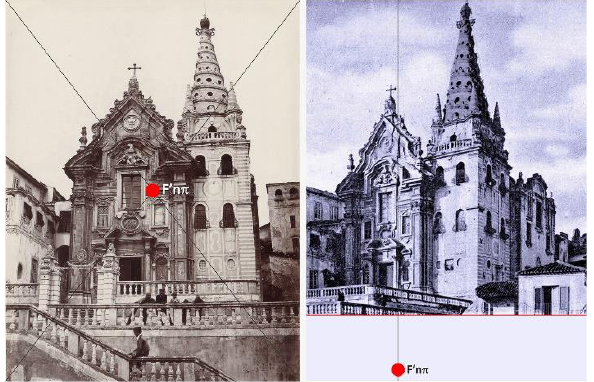
Figure 4: Photos of the lost church of San Gregorio in Messina, taken with a standard camera, or a view camera in neutral position (left) and with a view camera having the rear standard tilted